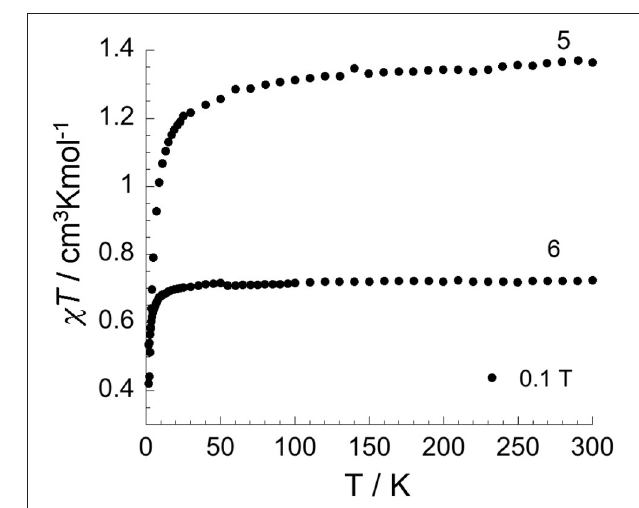
FIGURE 7 | Temperature dependence of χ T under 0.1T applied field for [V III 2 (dpt) 2 Cl 4 ] · H 2 O (1’) and [Cr III 2 (dpt) 2 Cl 4 ] · H 2 O (2’), with the fitted data using Equation (1) (red line).